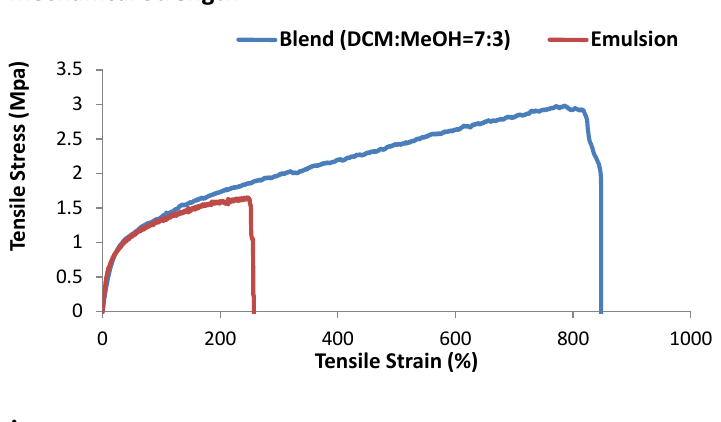
Figure 3. Comparison of mechanical strength of the scaffolds produced by different electrospinning